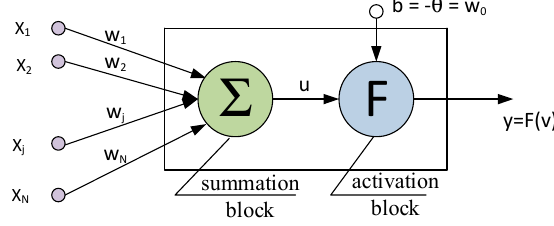
Figure 8. Model of an artificial neuron [13,42].